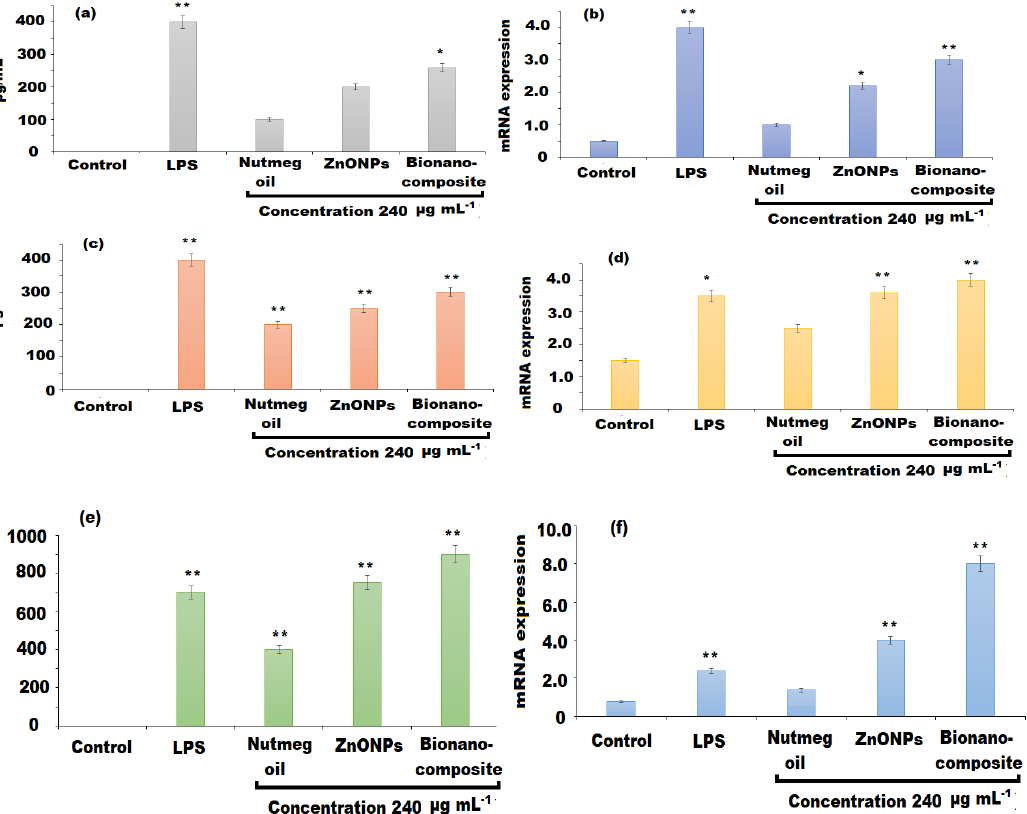
Figure 12. Effects of nutmeg oil, ZnONPs, and bionanocomposite on the levels of cytokines and mRNA expression ( a , b ) IL-6, ( c , d ) TNF- α , and ( e , f ) IL-10. (*) and (**) indicate ( p < 0.05) and ( p < 0.01) compared to the control